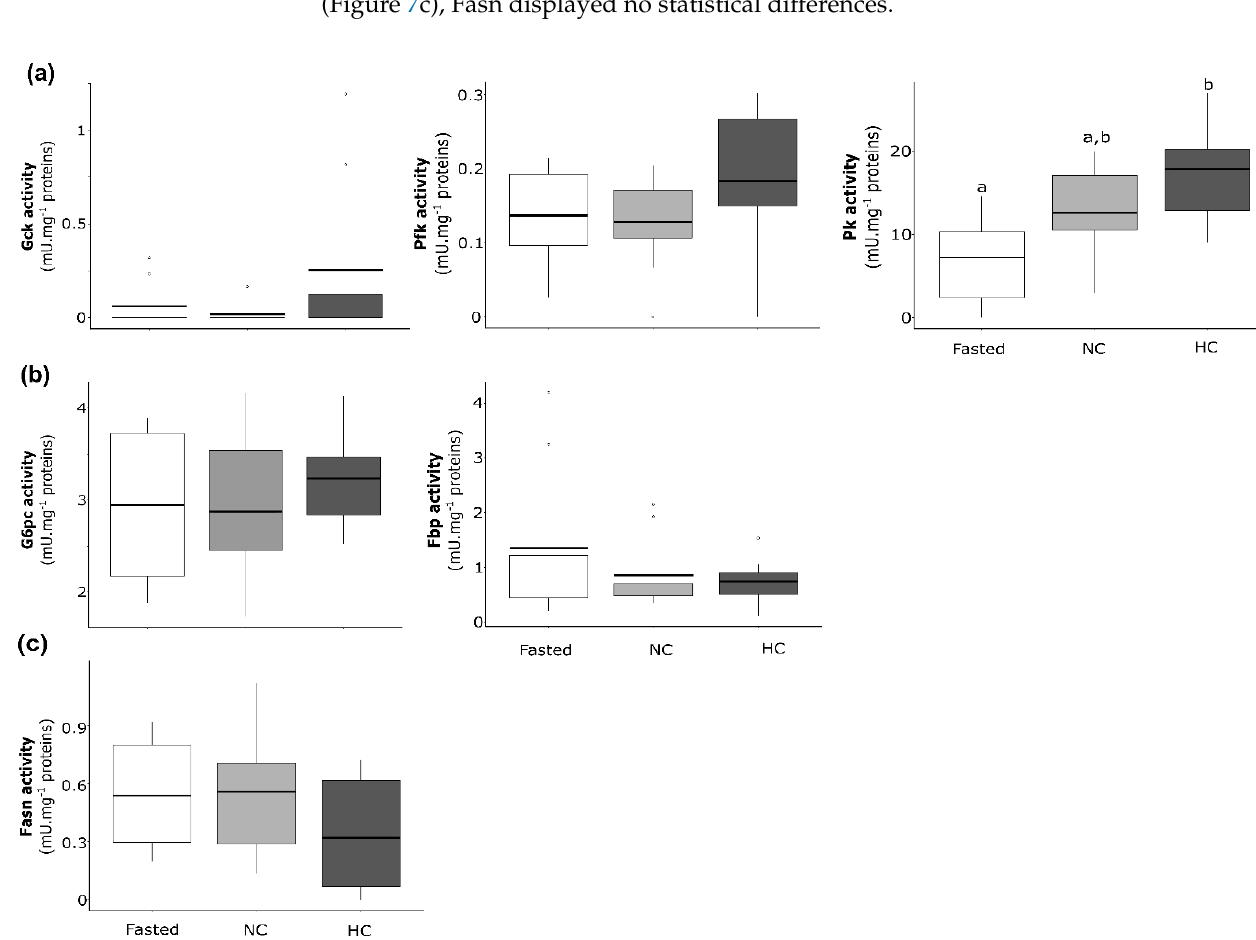
Figure 7. Enzymatic activities of glucose and lipid metabolism in the liver of neomale rainbow trout fasted for 15 days (Fasted, white), fed with a non-carbohydrate diet (NC, grey) and fed with a high-carbohydrate diet (HC, dark grey). Enzymatic activities are expressed as mU.mg −1 of proteins for ( a ) glycolysis with the glucokinase (Gck), the phosphofructokinase (Pfk) and the pyruvate kinase (Pk), ( b ) gluconeogenesis with the glucose-6-phosphatase (G6pc) and the fructose-1,6-bisphosphatase (Fbp) and ( c ) de novo lipogenesis with the fatty acid synthase (Fasn).